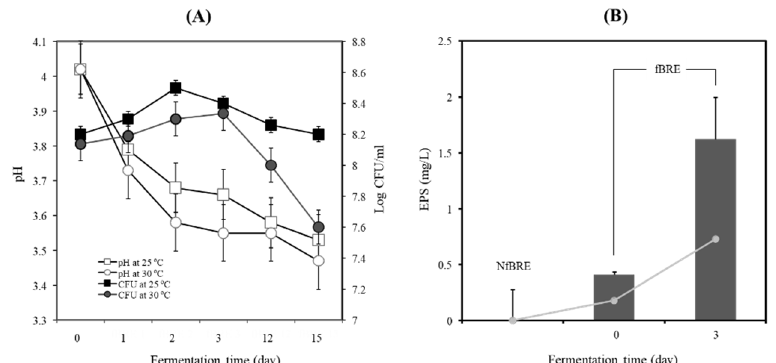
Figure 3. ( A ) Changes in pH, viable cell count, and ( B ) exopolysaccharide production of the fermented black raspberry extract by Pediococcus acidilactici M76. Cultivation was done for 15 days. log CFU/mL at 25 °C: ( ■ ), log CFU/mL at 30 °C: ( ● ), pH at 25 °C: ( □ ), pH at 30 °C: ( ○ ).